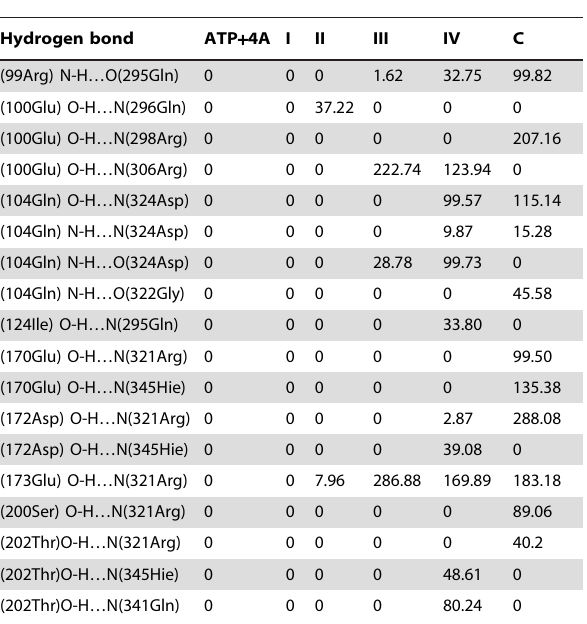
Table 5. The occupancies (%) of hydrogen bonds of the N- domain – C-domain interface in the ATP + eIF4A (ATP + 4A), I, II, III, IV and ATP + RNA + C-eIF4A (C)